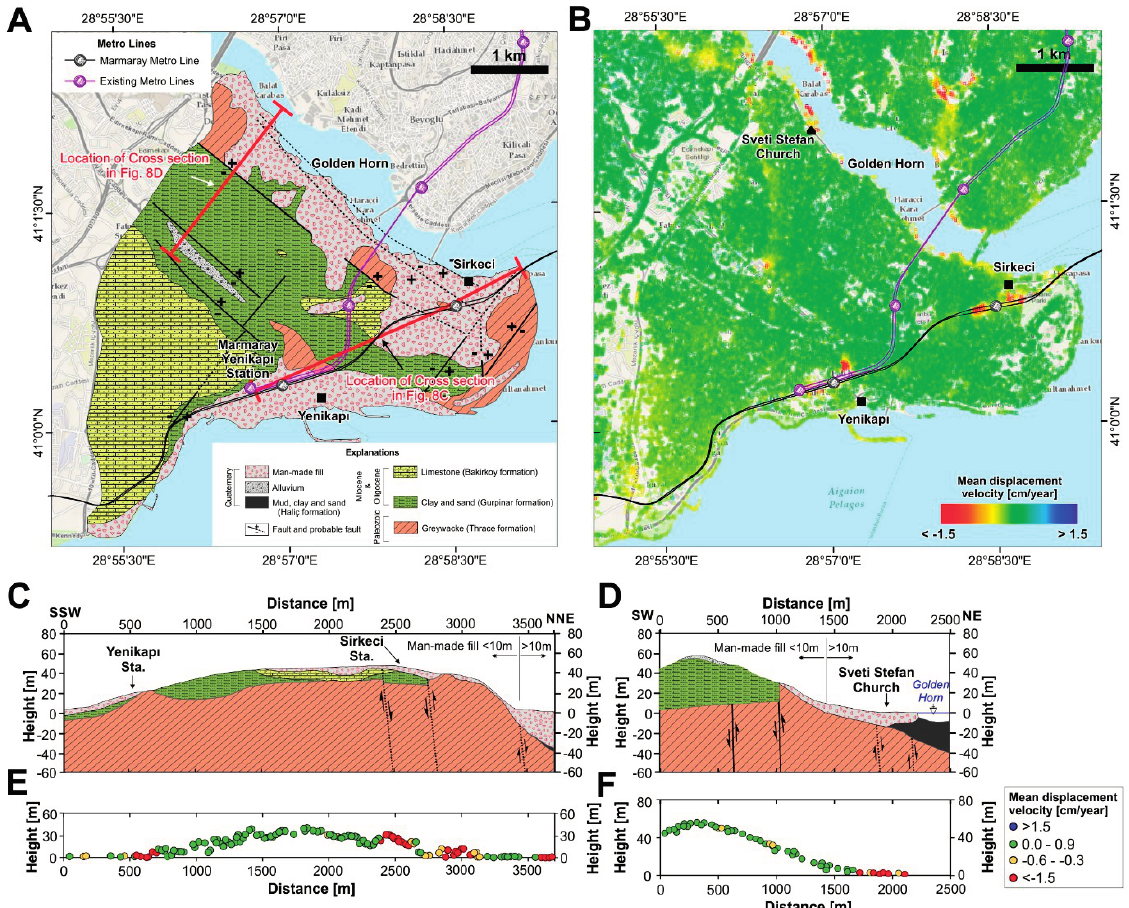
Figure 8. Historical Peninsula of Golden Horn: ( A ) Detailed geological map (modified after [68]). ( B ) Low resolution SBAS-DInSAR deformation velocity map. ( C , D ) Geological cross sections used for the analysis. ( E , F ) Profiles of DInSAR deformation velocity values along the geological sections in (C) and (D). Note that profiles in (C) and (E) correspond to the Marmaray